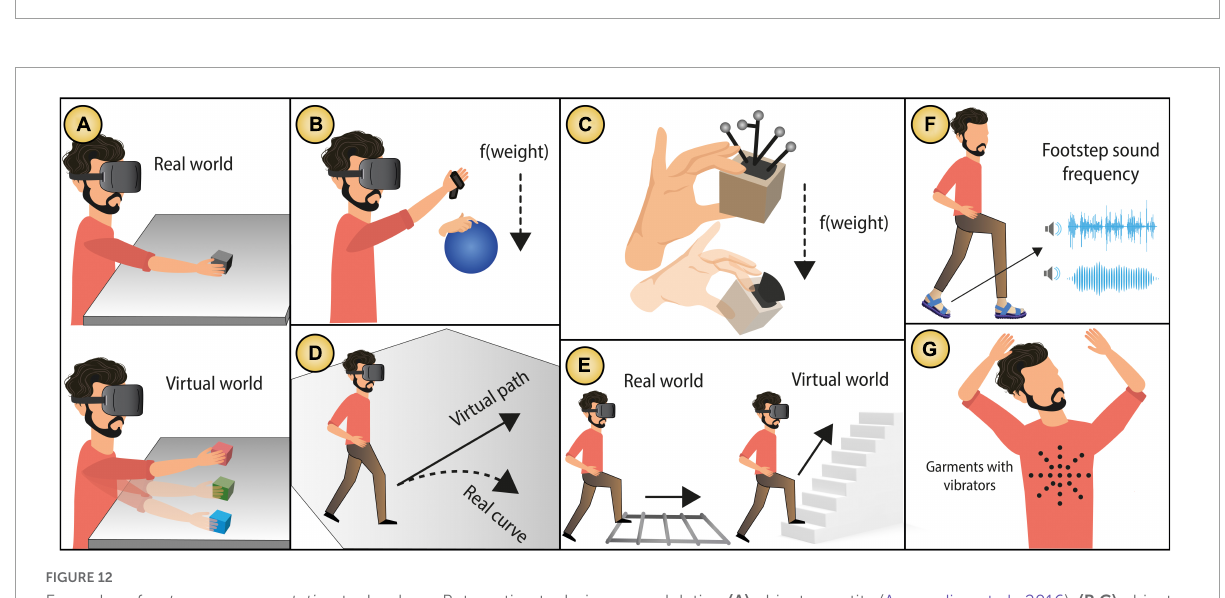
FIGURE11 Agency process for outcome augmentation technology. The system modulates the outcome to match the user’s intention.